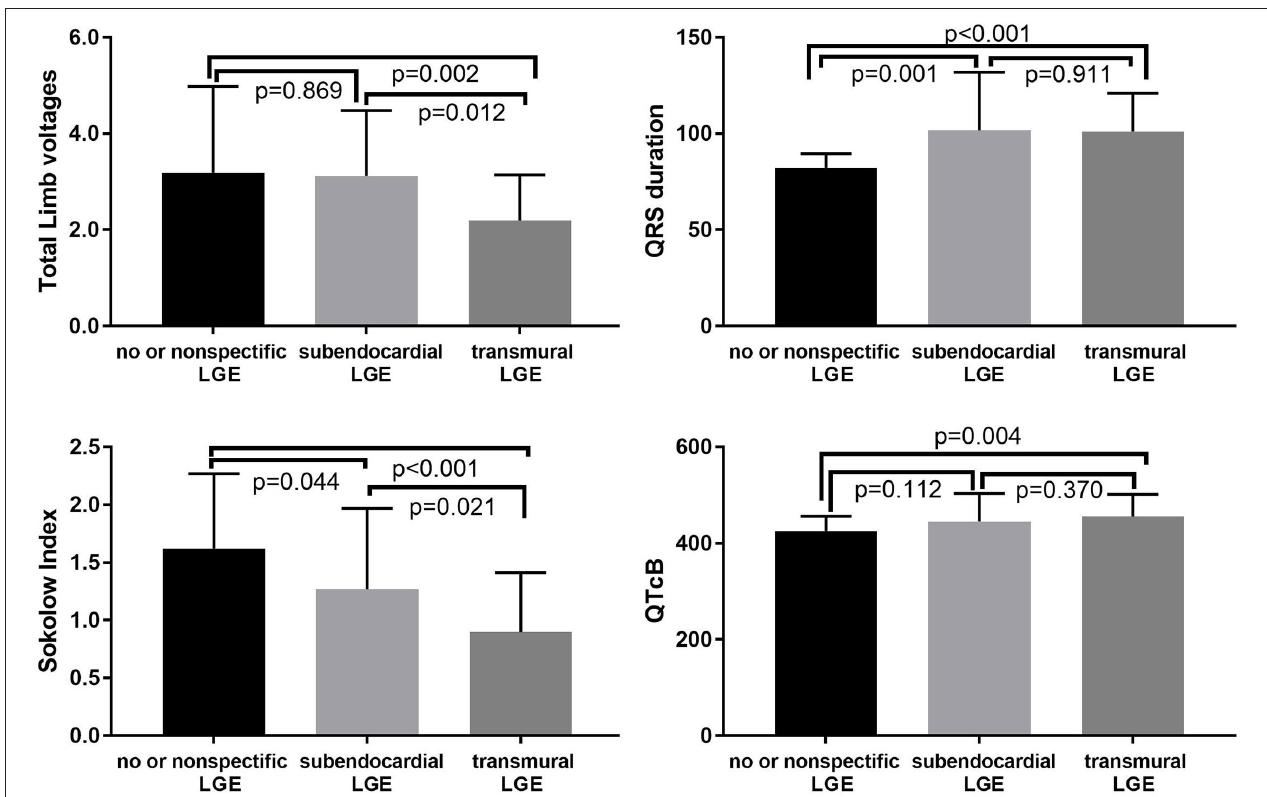
FIGURE 2 | Relationships between the LGE pattern and Sokolow index, QTcB, QRS duration, and total limb voltages.